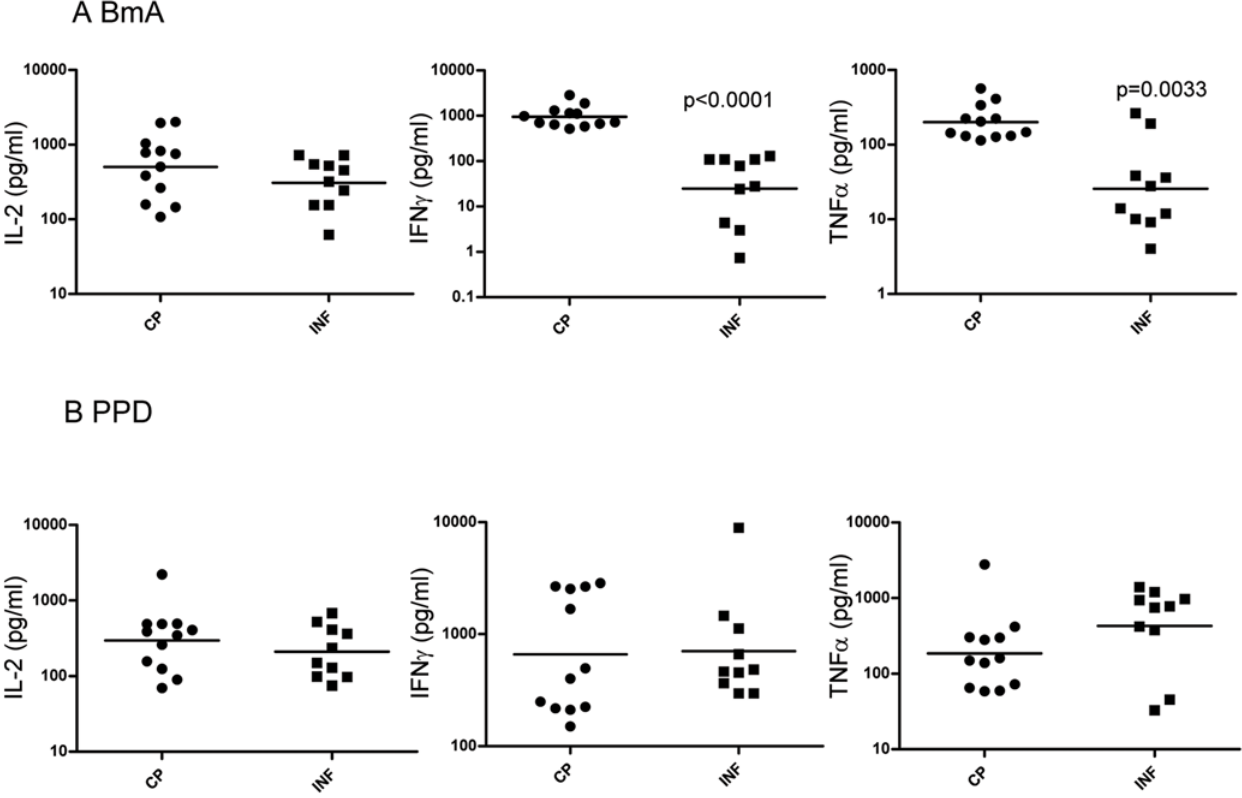
Figure 1. Filarial lymphedema is associated with elevated Th1 cytokine secretion. (A, B) PBMCs from filarial lymphedema [CP] ( n =12) and asymptomatic infected [INF] (n=10) patients stimulated with (A) BmA (10 m g/ml) or (B) PPD (10 m g/ml) for 24 hours, and Th1 - IL-2, IFN- c , and TNF- a cytokine levels were measured by ELISA. Results are shown as net cytokine production over media control. P values were calculated using the Mann- Whitney